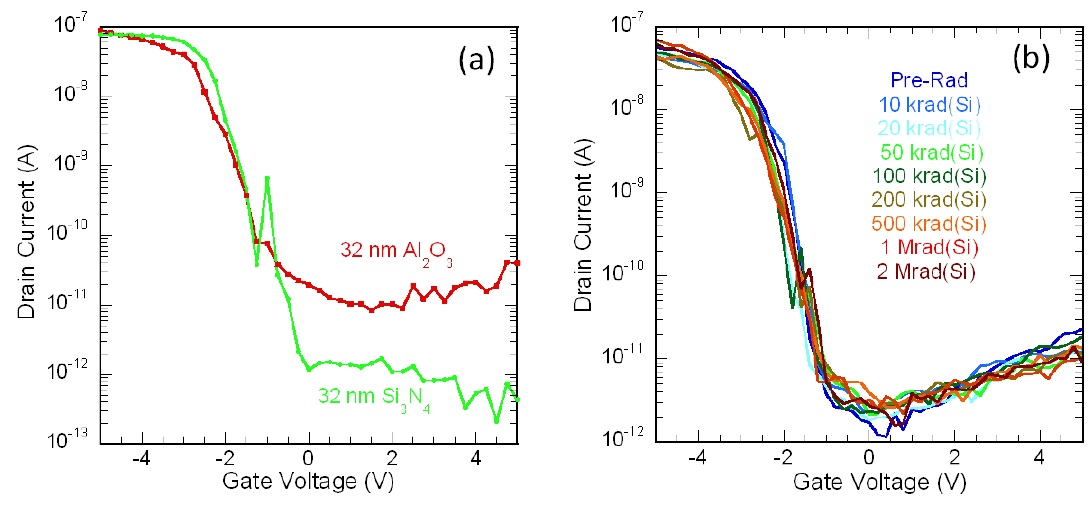
Figure 4. ( a ) Transfer characteristics of SWCNT-TFTs with 32 nm Al 32 nm SiON (green) gate dielectric layers; ( b ) The radiation response of SWCNT-TFT with a 23 nm SiON gate dielectric